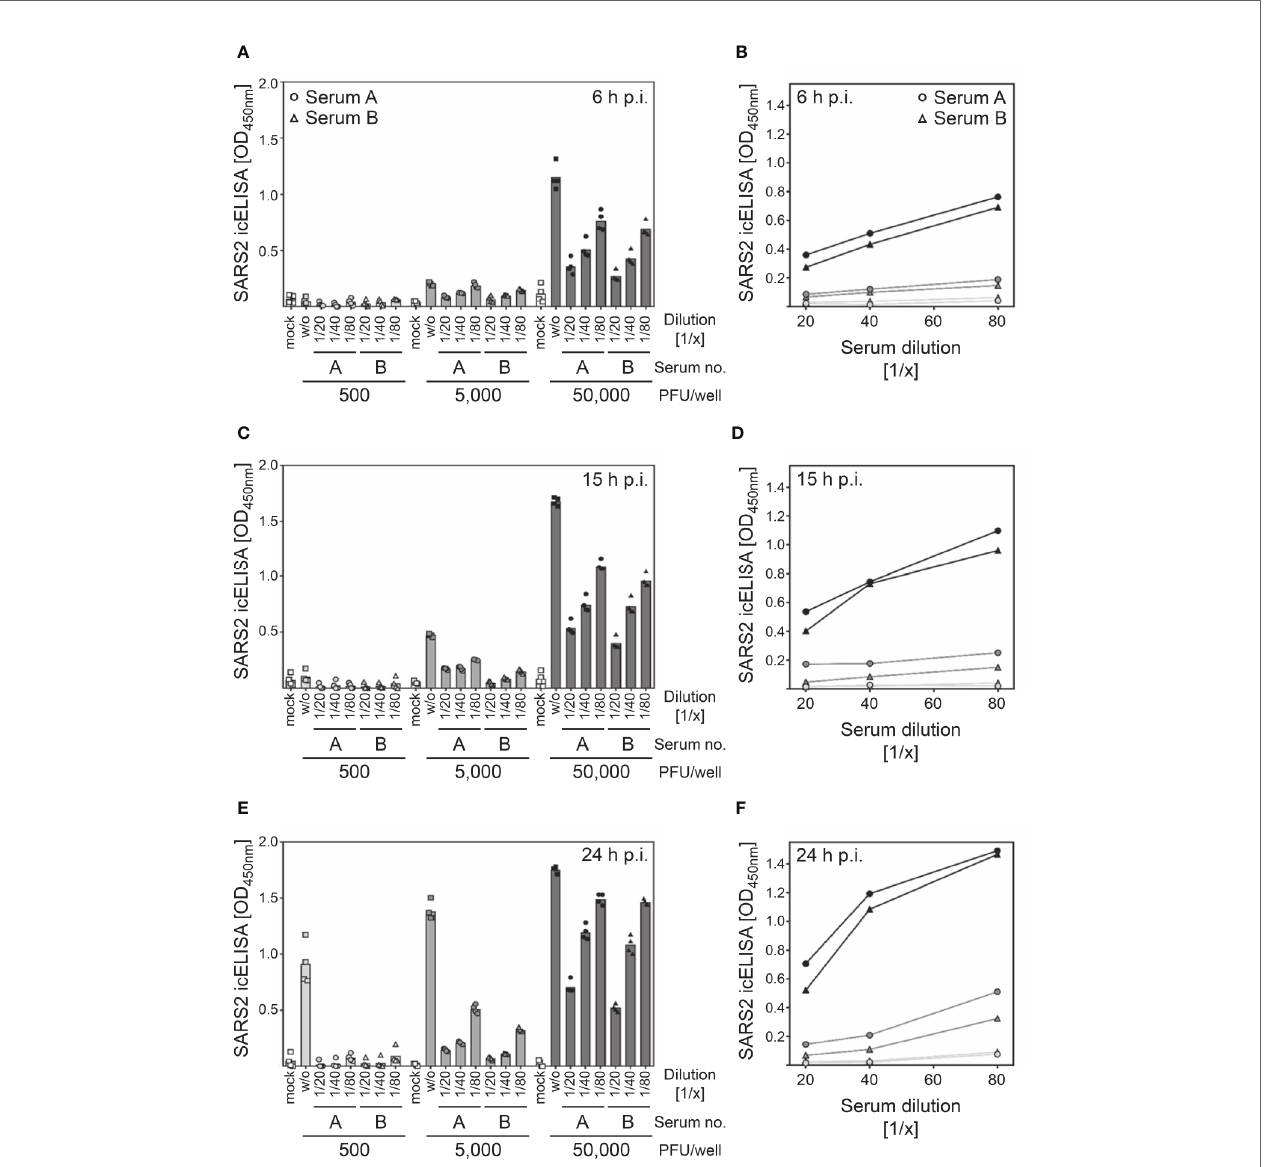
FIGURE 3 | The icNT allows the quanti fi cation of SARS-CoV-2 NAbs as early as 6 h p.i. (A – F) 500, 5,000, and 50,000 PFU of SARS-CoV-2 were incubated with indicated dilutions of 2 convalescent sera for 1 h before Vero E6 cells were infected. At 6 h p.i. (A, B) , 15 h p.i. (C, D) , and 24 h p.i. (E, F) , cells were analyzed by icELISA to evaluate the neutralizing capacity of the sera. (A, C, E) Bars depict the mean values. Squares, dots, and triangles show the values of the individual measurements. (B, D, F) All mean values of the different serum dilutions and virus doses were depicted in one diagram to compare the in fl uence of the input virus amount on the course of the curve. Light gray, 500 PFU. Gray, 5,000 PFU. Dark gray, 50,000 dilution. Thus, we concluded that the icNT principle allows virus (8,000 PFU/well). While all positive sera clearly neutralized the low infectious dose of 200 PFU/well ( Figures 5A – C ), the neutralizing capacity of the same sera considerably differed at the more restrictive high virus dose ( Figures 5D – F ). This advantage of the icNT compared to the PRNT was especially evident when a